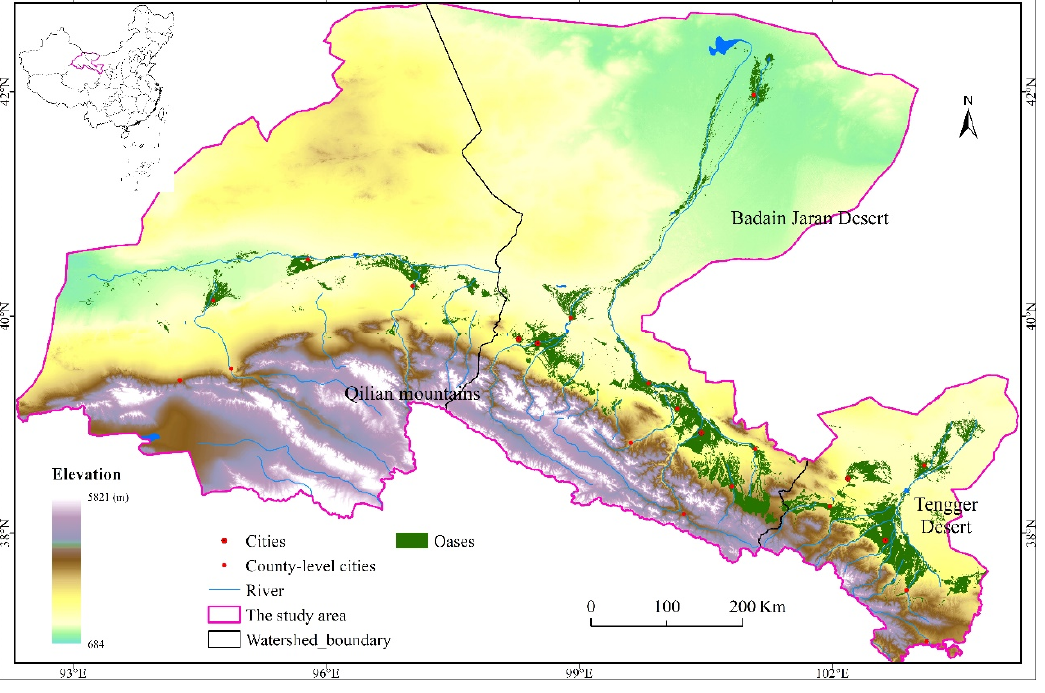
Figure 1. The study area in northwest China and its main features.